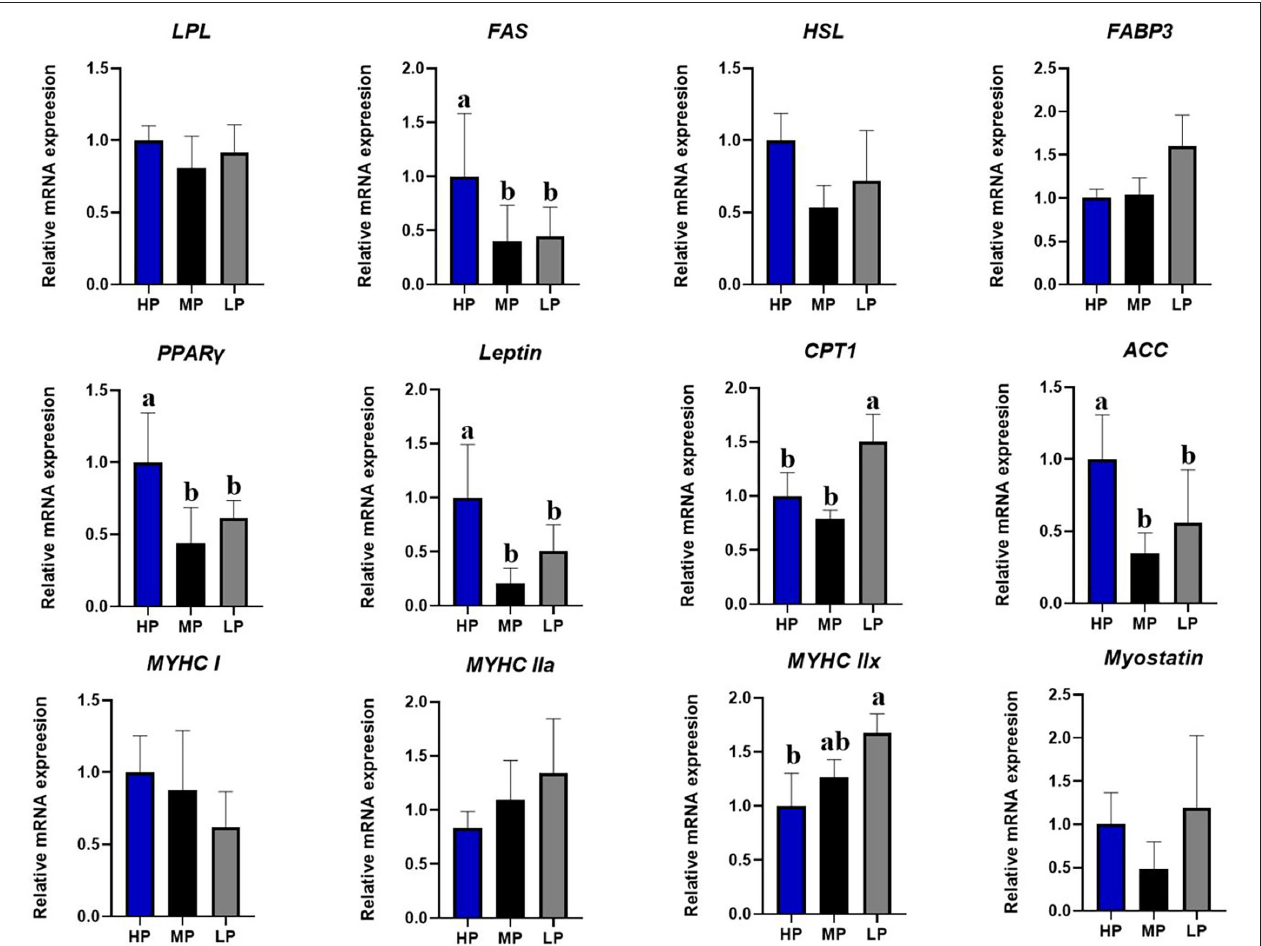
FIGURE 2 | Effect of low-protein diet on the relative mRNA expression levels of muscle genes in finishing pigs. LPL, Lipoprteinlipase; FAS, fatty acid synthetase; HSL, hormone-sensitive lipase; FABP3, fatty acid binding protein 3; PPAR γ , peroxisome proliferator activated receptor gamma; CPT1, carnitine palmitoyl transferase 1; ACC, acetyl-CoA carboxylase; MYHC, myosin heavy chain; HP, high protein (16% crude protein); MP, medium protein (12% crude protein); LP, low protein (10% crude protein). a − c Column with different numbers indicate that there is a significant difference among different treatments ( P <